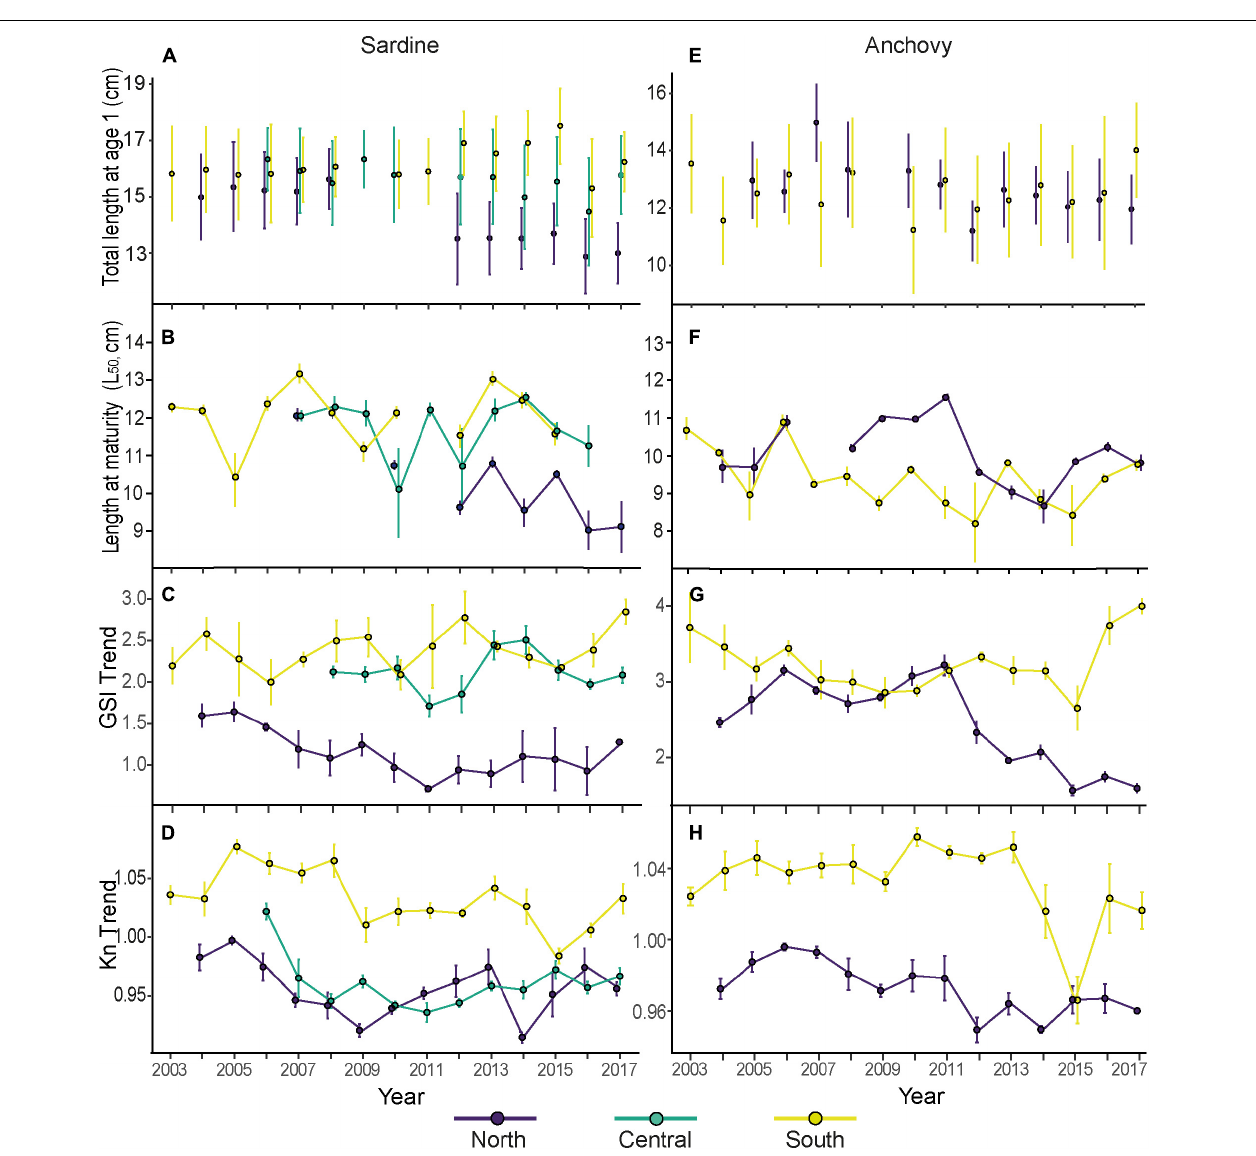
FIGURE 2 | Summary figure with annual mean and standard deviation values of total length of age 1 (see Supplementary Figures 2, 3 for a plot of all ages) (A,E) , mean and standard error of length at maturity (L 50 ) (B,F) , mean and standard deviation values of the gonadosomatic index trend (values obtained after decomposition; GSI trend) (C,G) and trend of the relative condition factor (values obtained after decomposition; Kn trend) (D,H) . All values are reported by species, for sardine on the left and for anchovy on the right side. Each color represents an area (North, Central, and